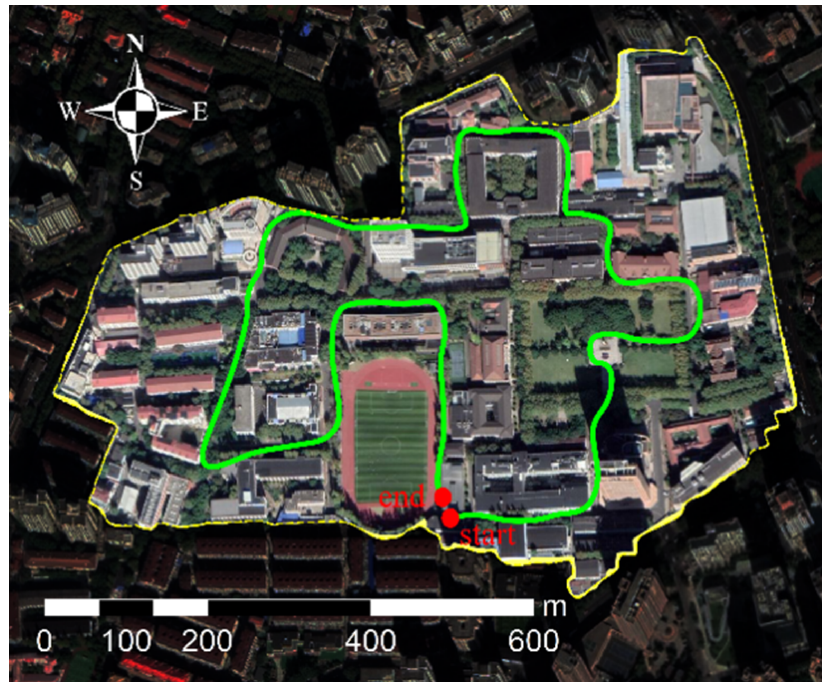
Figure 3. Mobile measurement roadmap.